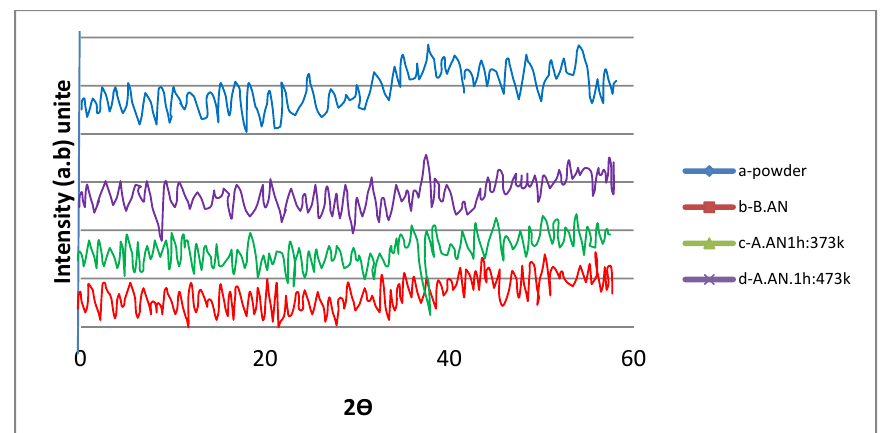
Fig. 2: X-ray diffraction of Ge